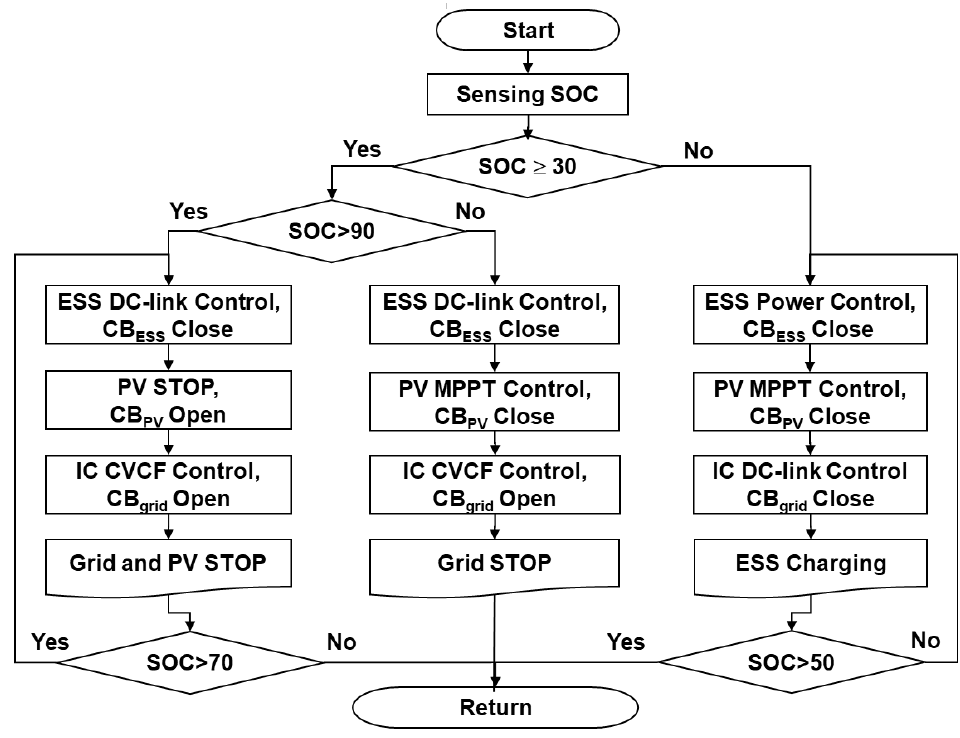
Figure 8. The proposed supervisory power coordination scheme without a VPP request.